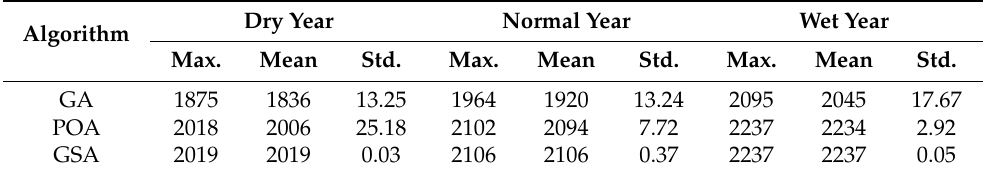
Table 5. Comparison of power generation (10 8 kWh) among different methods.